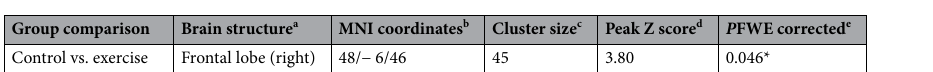
Table 4. Voxel-wise: longitudinal analysis taking into consideration the influence of polymorphic allele e4 of the apolipoprotein e and time interval in patients with obstructive sleep apnea undergoing exercise training or clinical follow-up. FWE , indicates family-wise error. a Each region was circumscribed using the small volume correction approach, with anatomically defined volume-of-interest masks. b MNI (Montreal Neurological Institute) coordinates of the voxel of maximal statistical significance with each cluster. c Number of contiguous voxels that surpassed the initial threshold of P < 0.005 (uncorrected) in the statistical parametric maps. d Z scores for the voxel of maximal statistical significance. e Statistical significance after correction for multiple comparisons (voxel level). *Refers to statistically significant